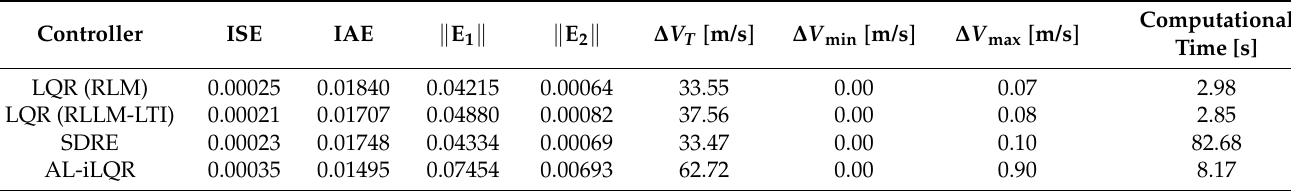
Table 4. Performance comparison for the continuous guidance schemes.